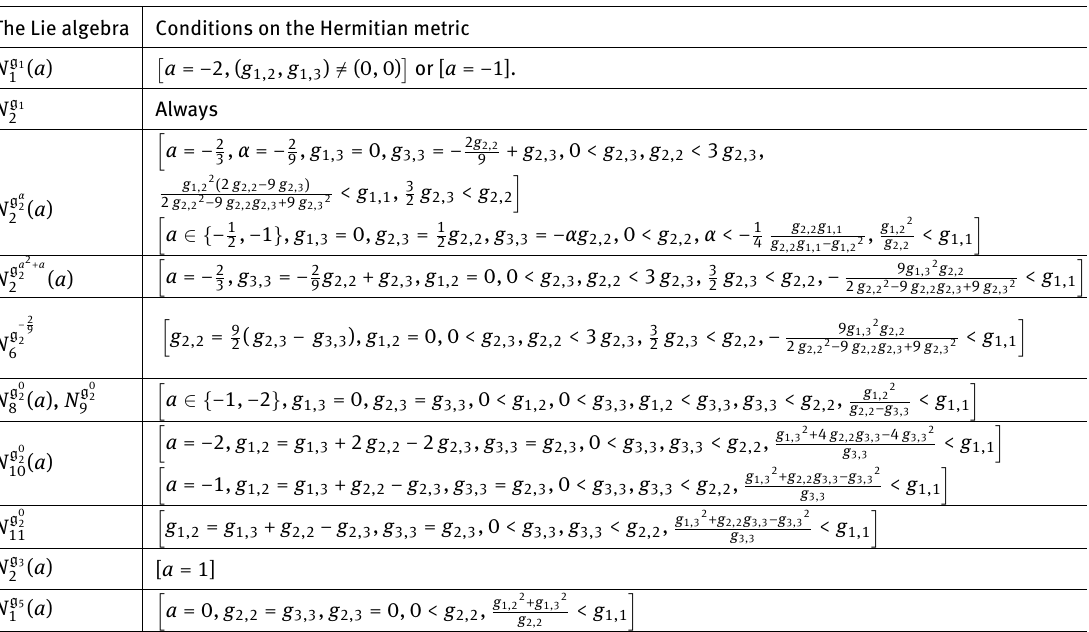
Table 7: Examples of pluriclosed non Kähler Lie algebras.